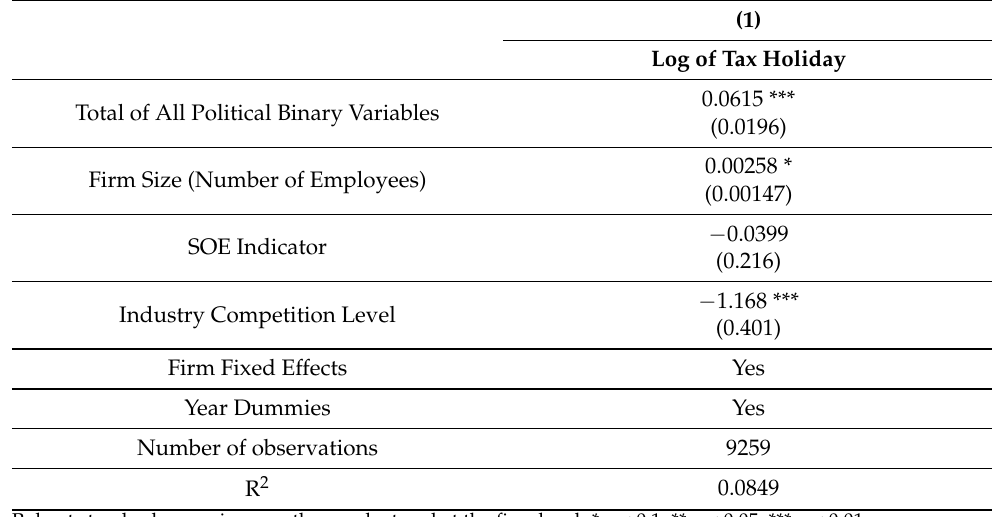
Table 8. Effects of Political Connectedness (one proxy) on Tax Holiday Allocations.